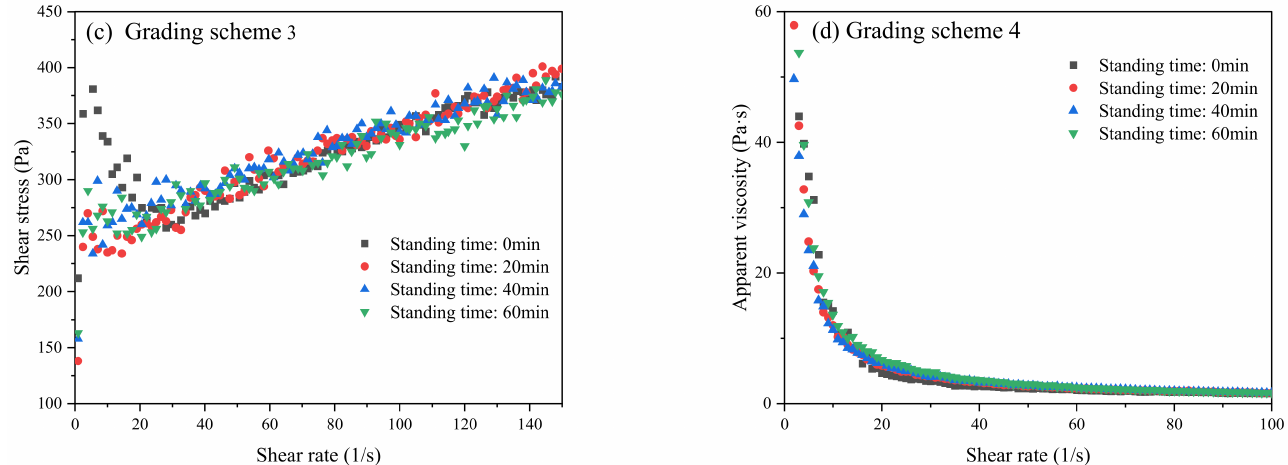
Figure 11. Shear stress & shear rate curve in different grading schemes at 75% mass fraction. ( a ) Grad-